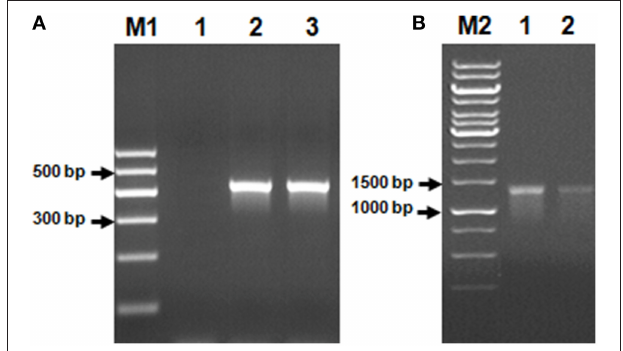
FIGURE 5 | Genes of the 4S biodesulfurization pathway detected in the AK6 mixed culture. Genomic DNA from the reference strain R. erythropolis was included as a positive control. Lane A1 : negative (no-template) control, lane A2 : dszB gene in the reference strain, lane A3 : dszB gene in AK6, lane B1 : dszC gene in the reference strain, lane B2 : dszC gene in AK6. M1 and M2 are DNA